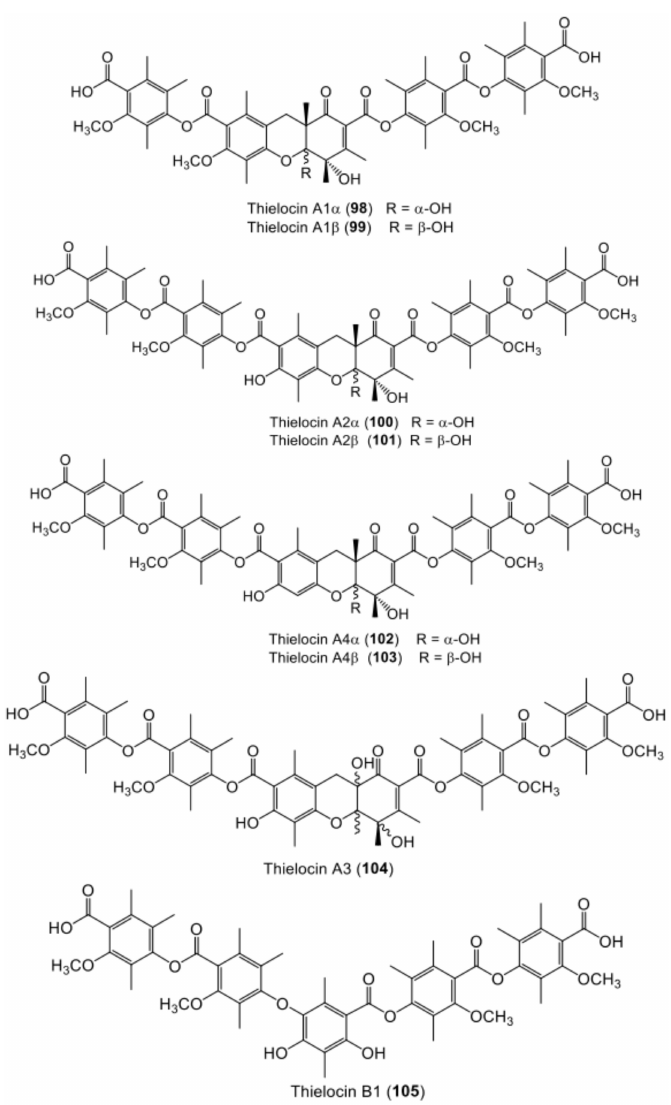
blood glucose levels in NA-STZ (nicotinamide-streptozotocin) diabetic mice, indicating that 59 (doses of 3.1 and 10 mg/kg) reduced the blood glucose levels in both diabetic and normal mice [67].